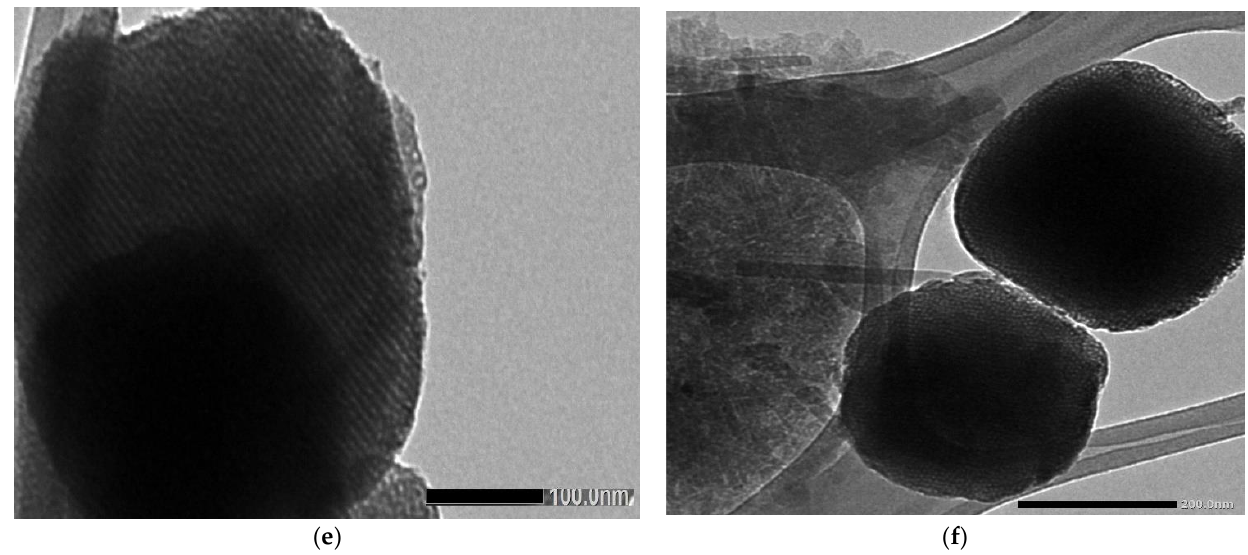
Figure 2. (a , b ) SEM images; ( c ) electronic image corresponding to EDX analysis; ( d ) EDX spectrum; ( e , f ) TEM results of the ball-mill-fabricated CNPs.